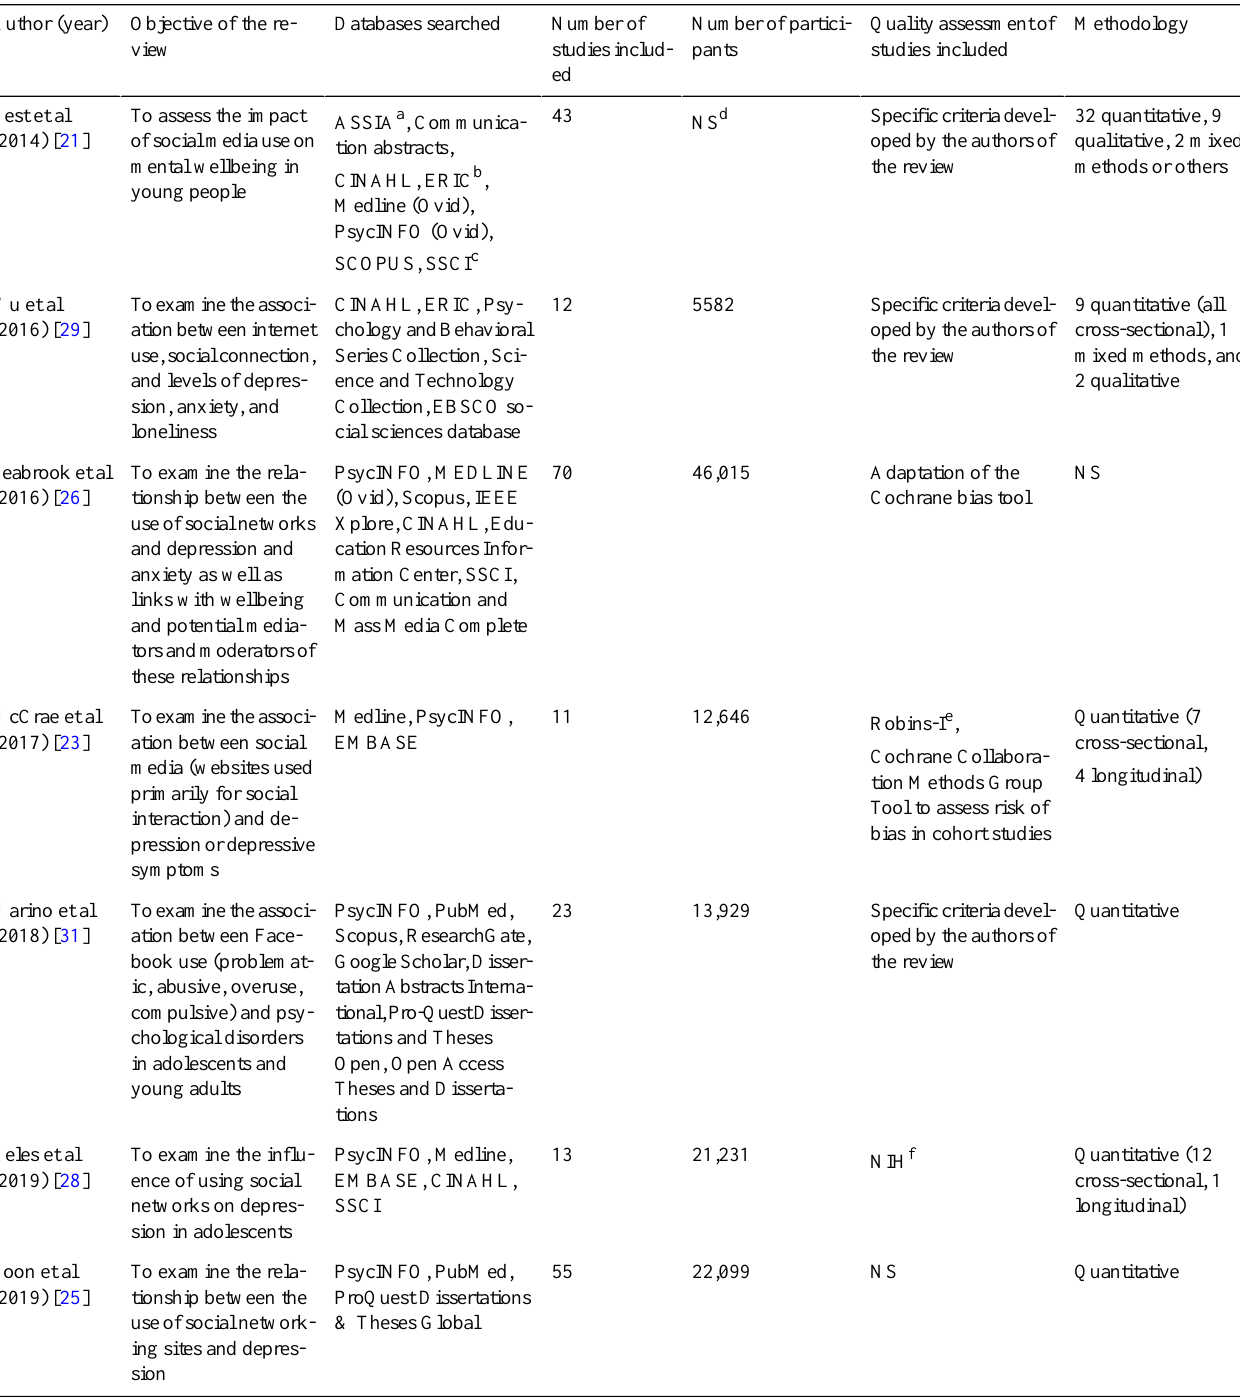
Table 1. Characteristics of the included